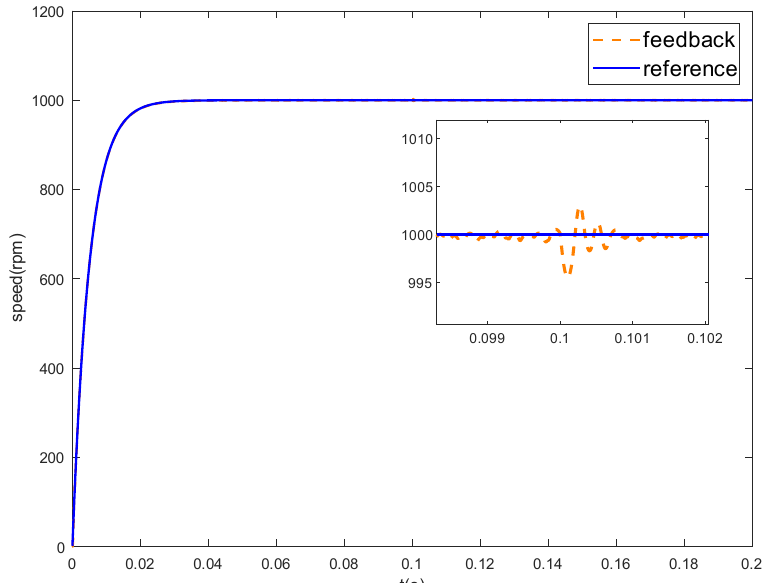
14 of 18 Figure 17. Characteristic parameter identification curve of 0 ( ) g k . 5.1.3. Load Performance Analysis In order to verify the anti-disturbance of the proposed method, a loading simulation experiment was carried out on the system. The rated torque of the motor used was 0.318